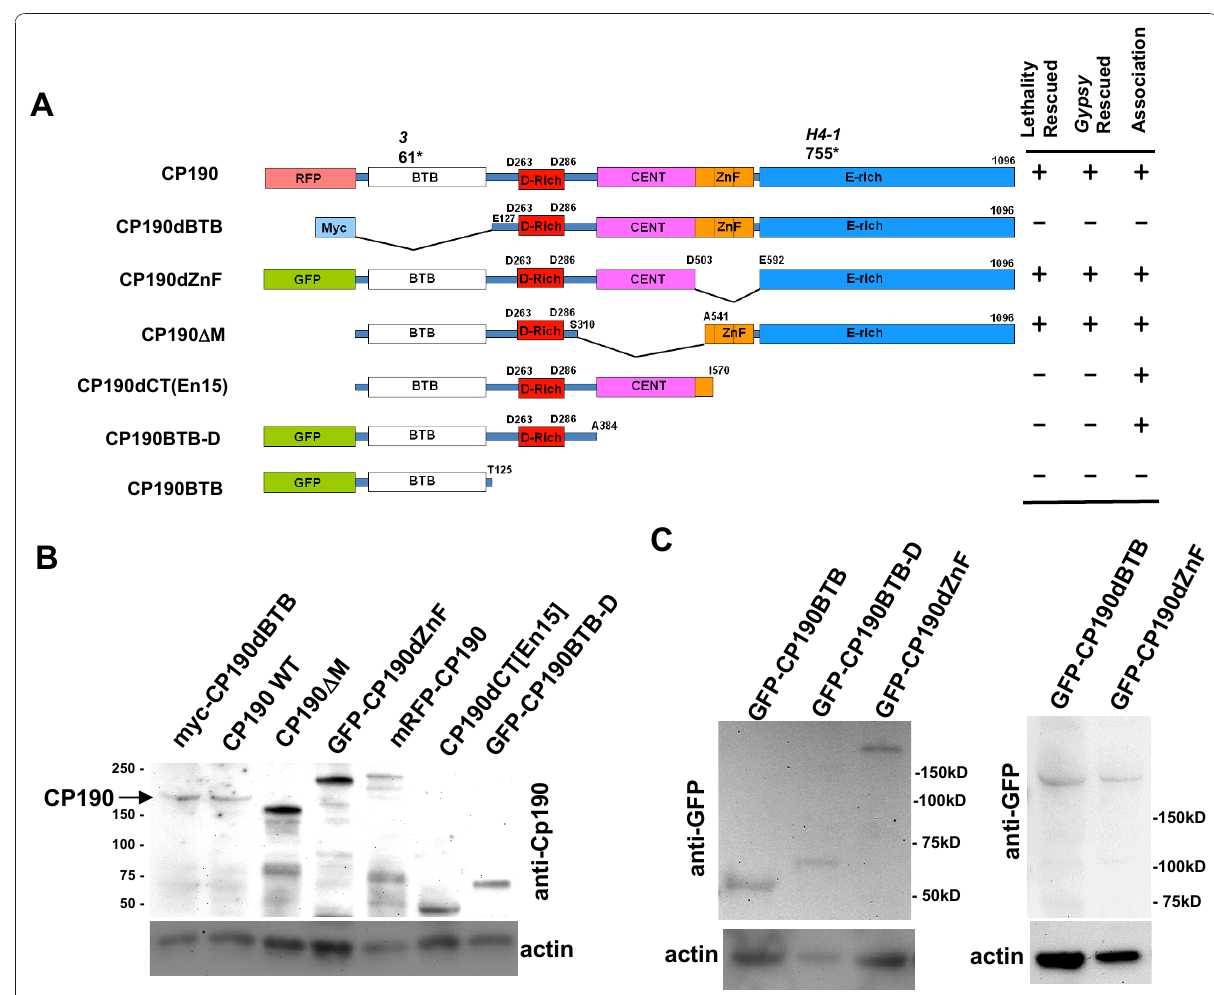
Figure 1 Protein structure and expression levels of CP190 deletion mutants . (A) Schematic diagram of CP190 deletion mutants and their genetic complementation phenotypes. The full-length Cp190 is tagged with mRFP (mRFP-CP190). Each CP190 mutant contains a deletion of one of the functional domains. CP190dBTB lacks the BTB domain and is tagged with myc (myc-CP190dBTB) or with GFP (GFP-CP190dBTB, not shown); CP190dZnF lacks all three zinc fingers and is tagged with GFP (GFP-CP190dZnF); CP190 Δ M lacks the centrosomal targeting domain (CENT); CP190BTB-D lacks CENT, zinc fingers and the E-rich domain and is tagged with GFP (GFP-CP190BTB-D); CP190BTB has only the BTB domain and is tagged with GFP (GFP-CP190BTB). The CP190dCT(En15) is the predicted protein from the EMS-induced CP190 En15 mutant, which lacks two zinc fingers and the E-rich region. The amino acids at the junction of each deletion are indicated. (B-C) Expression of the mutated Cp190 proteins revealed by the anti-CP190 immunoblot (B) or by anti-GFP immunoblots (C). All transgenic lines were crossed into the homozygous CP190 3 background. Proteins extracted from about two 3 rd instar larvae containing the indicated transgene were loaded per each lane. Similar results were also obtained from pupae 24-48 hours after pupation. Underneath the blots were stripped filters re-probed with the anti-actin antibody as a loading